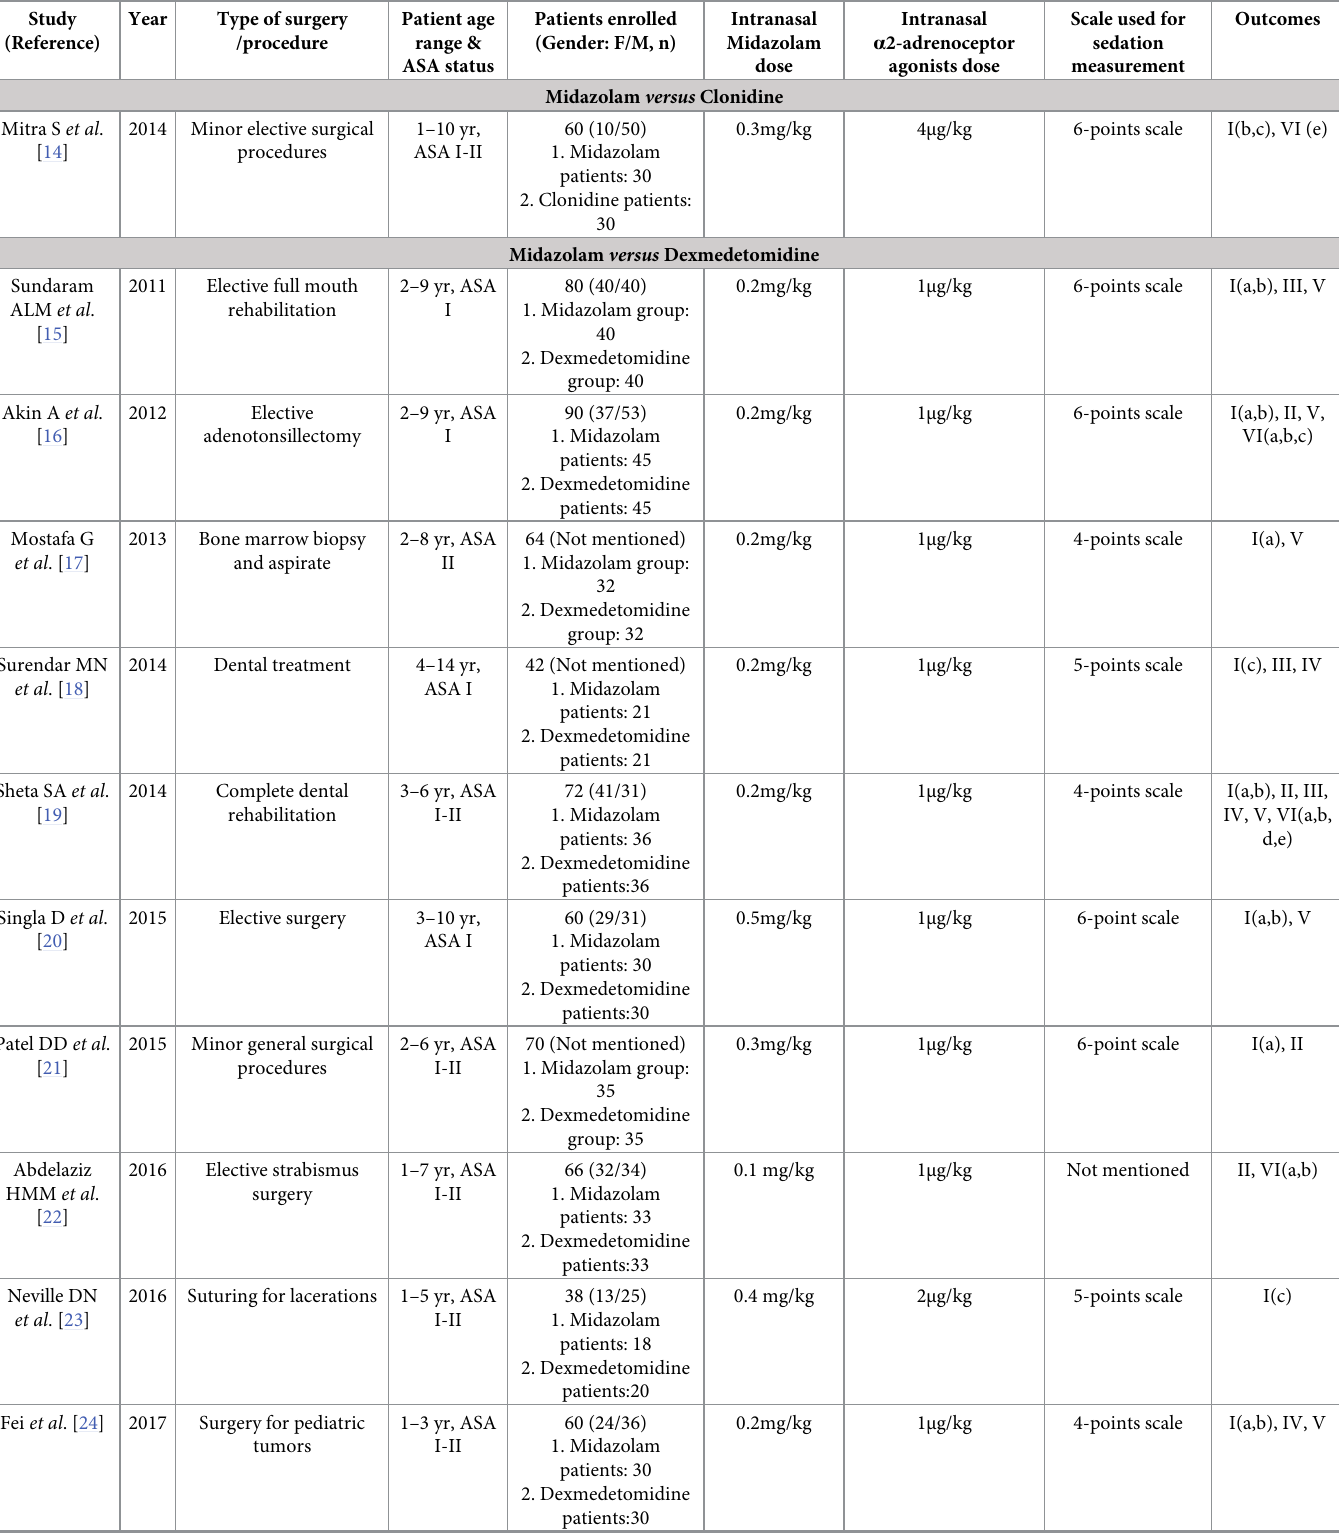
Table 1. The general characteristics of the enrolled studies. Study